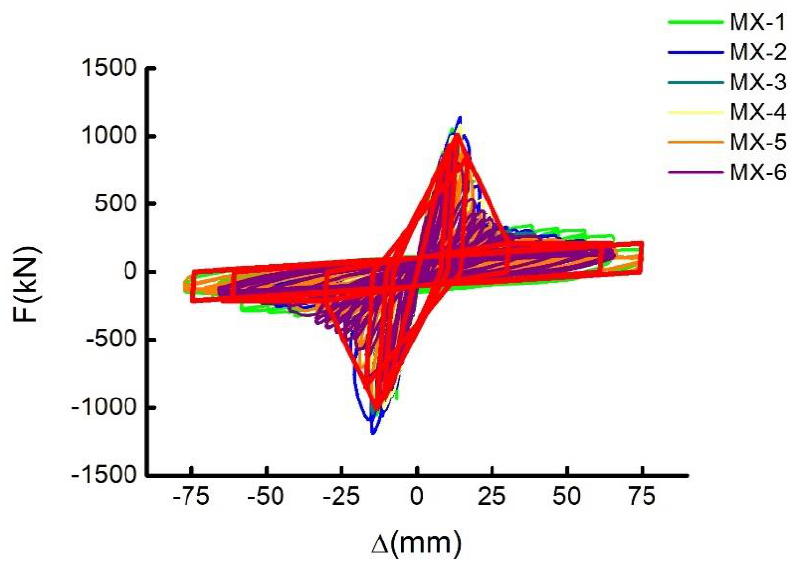
Figure 13. Comparison between the calculated restoring force and the experimental hysteresis model.